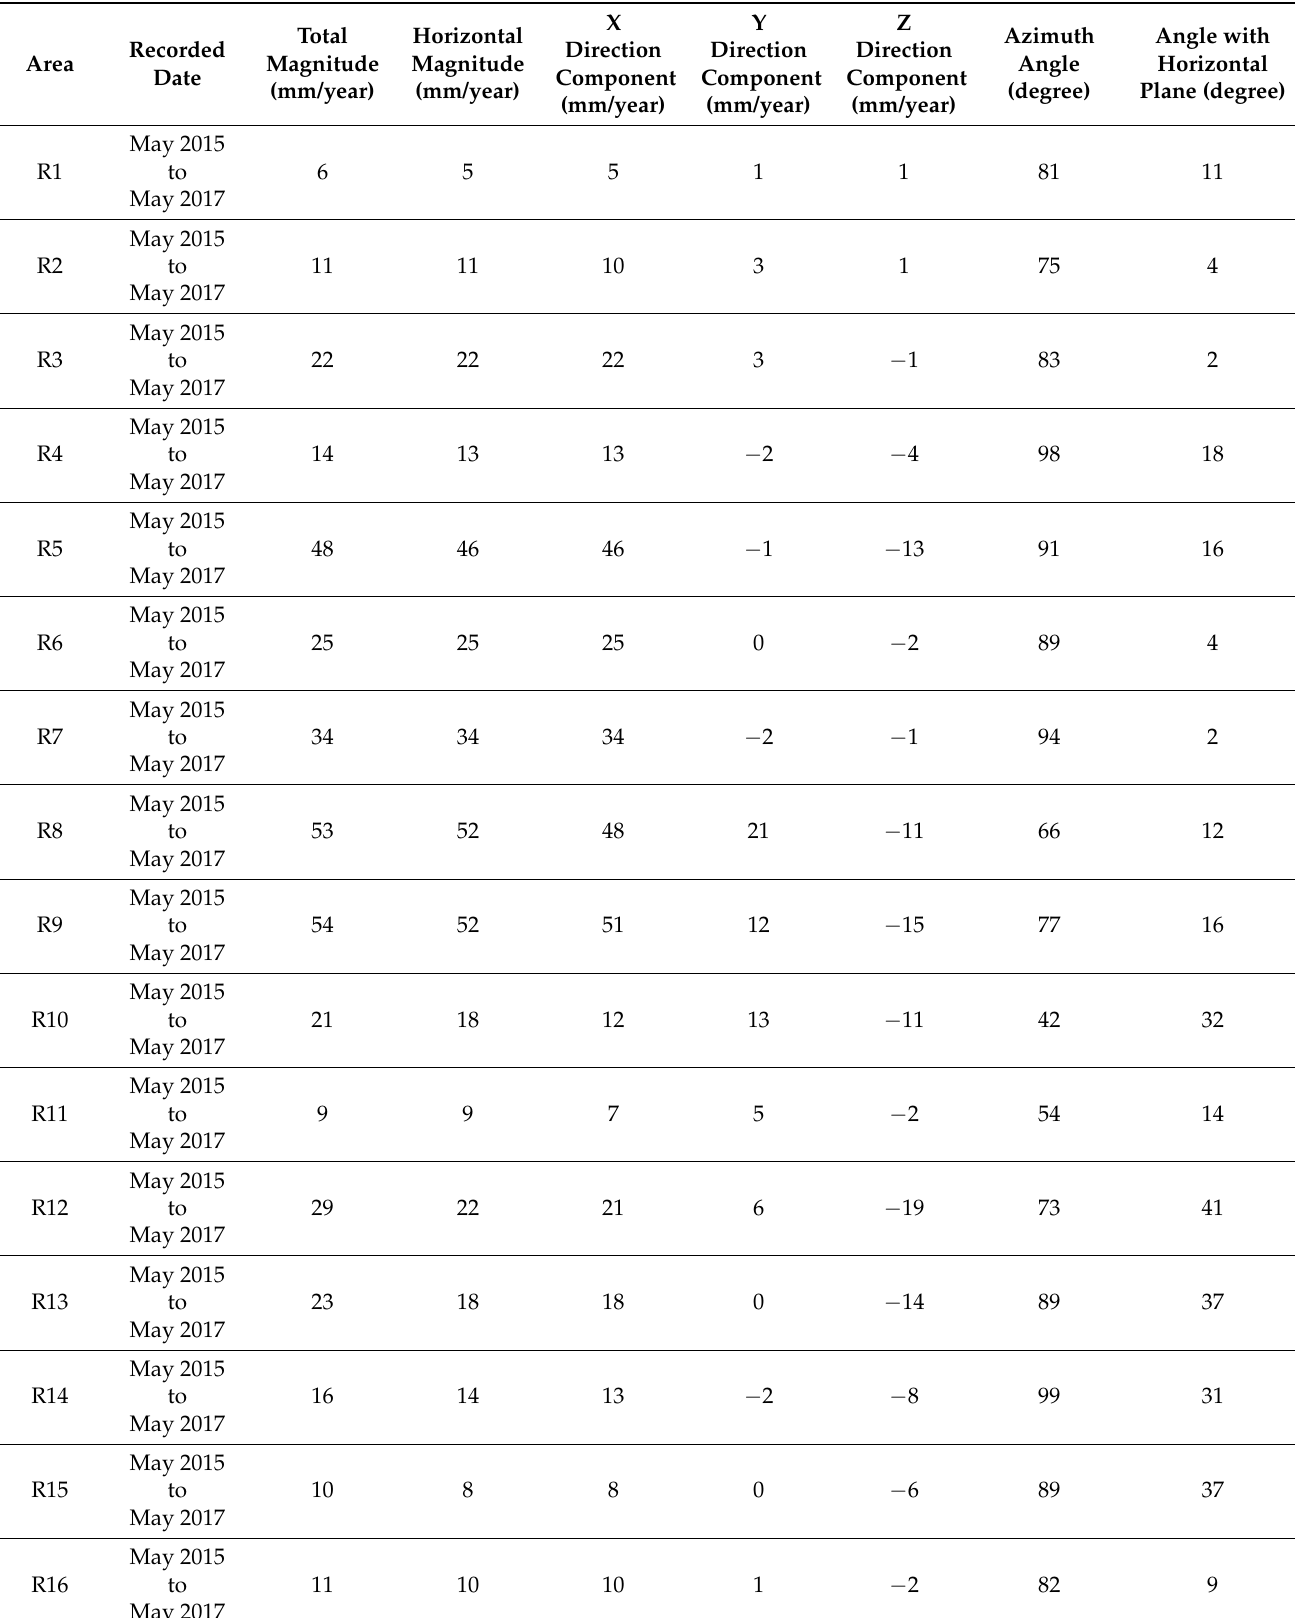
Table 8. Summary of calculated R magnitude, components, and geometry on the Redhill